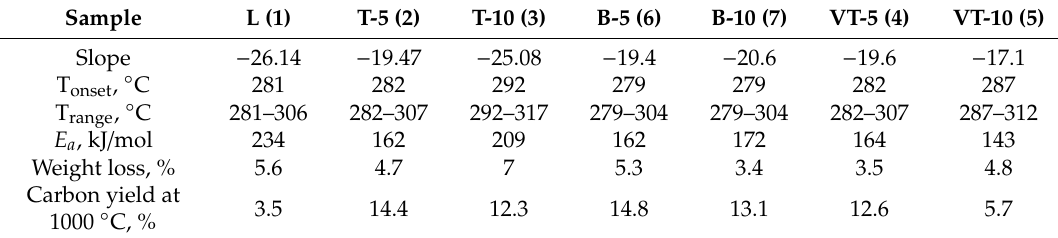
Figure 6. Dependence ln(ln(1 / y )) VS 1000 / T for determining the activation energy of the thermal decomposition. Table 4. DTG data for cellulose and composite fibers.